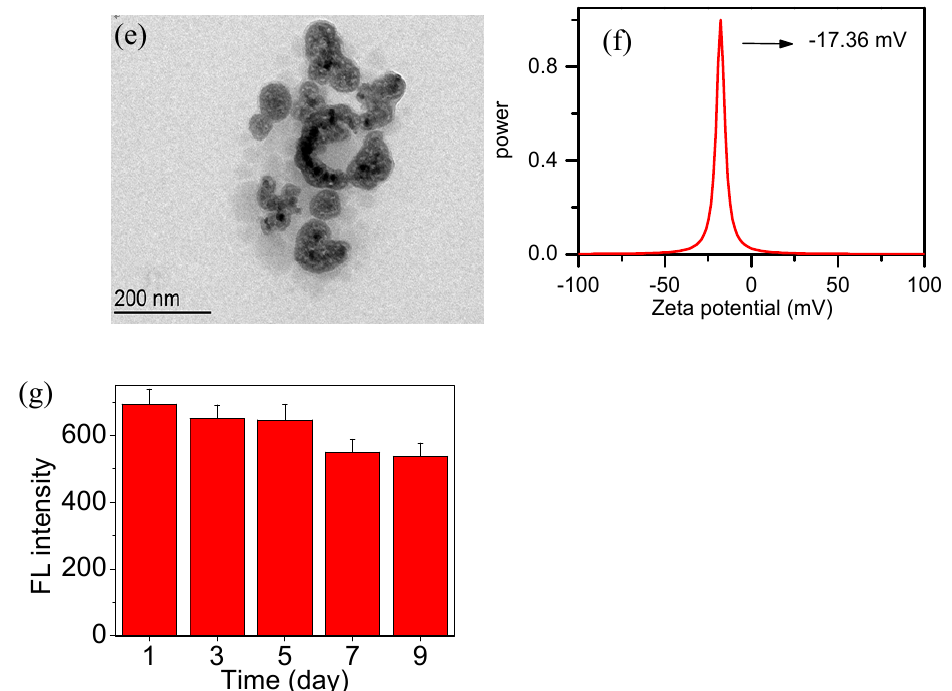
Figure 2. ( a ) Schematic illustration of AIE–Fe nanodots formation. ( b ) Dynamic Light Scattering (DLS) ( c ) absorption, ( d ) emission ( λ ex = 494 nm), ( e ) Transmission Electron Microscope (TEM), ( f ) Zeta potential spectrum and ( g ) fluorescence intensity of AIE–Fe nanodots for storing different time at room temperature (nanodots composition: 5 mg TPAS, 5 mg Fe 3 O 4 , 10 mg Pluronic F-127 in 10 mL water).